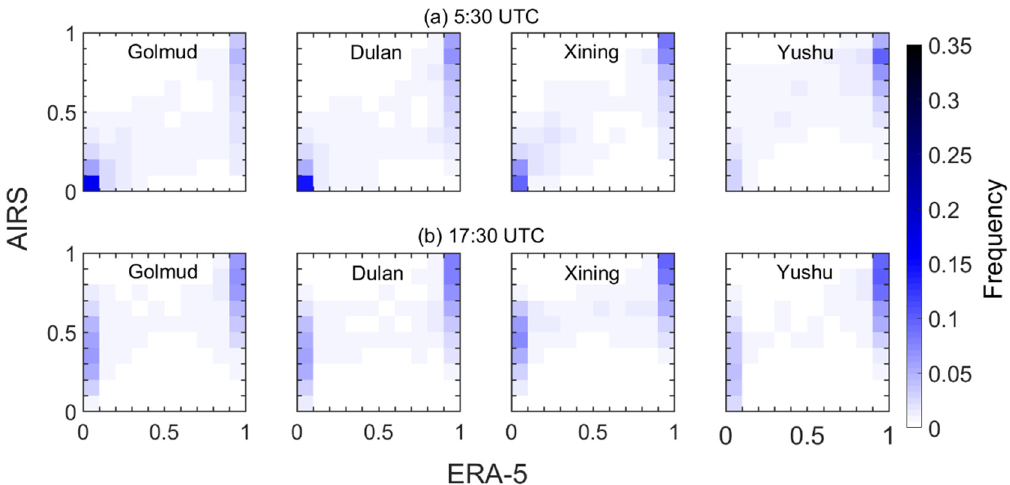
Figure 7. ERA-5 and AIRS total cloud cover coincidence frequency diagram. ( a ) At 5:30 UTC, the coincidence frequency of the total cloud cover at each station. ( b ) At 17:30 UTC, the coincidence frequency of the total cloud cover at each station.